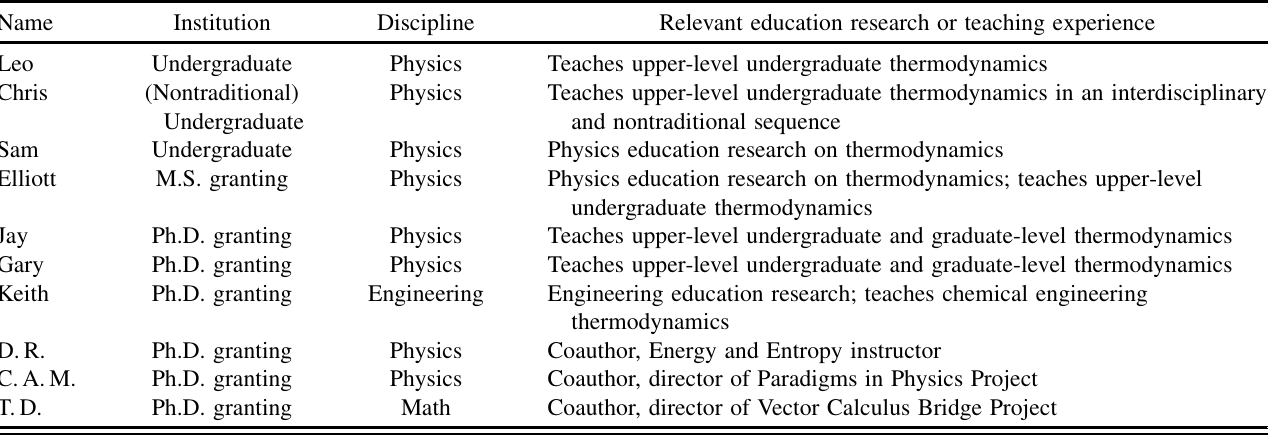
TABLE II. Background of faculty interviewees, including relevant teaching experience and education research. Some also conduct traditional physics research involving thermodynamics, which we have not included. Although we only mention thermodynamics below, many of the courses include a significant statistical mechanics portion as well.